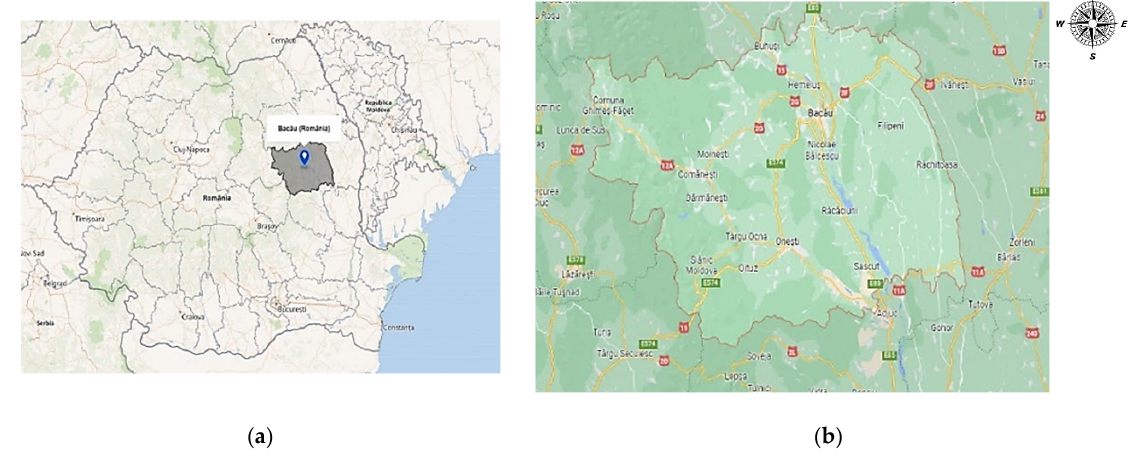
Figure 4. Location of Bacau County at the level of Romania Country ( a ) and the borders of Bacau County ( b ).